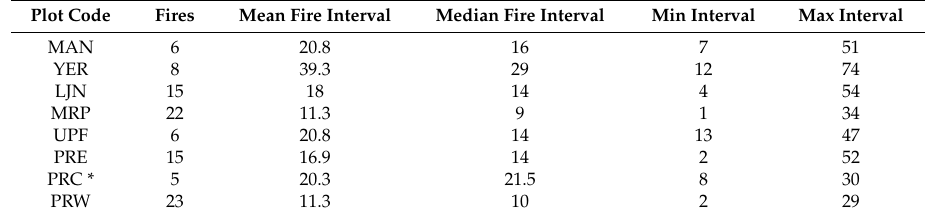
Table 2. The plot composite fire interval statistics (years) during the common period 1600–1899. The plots are ordered from north to south. See Table 1 for the plot